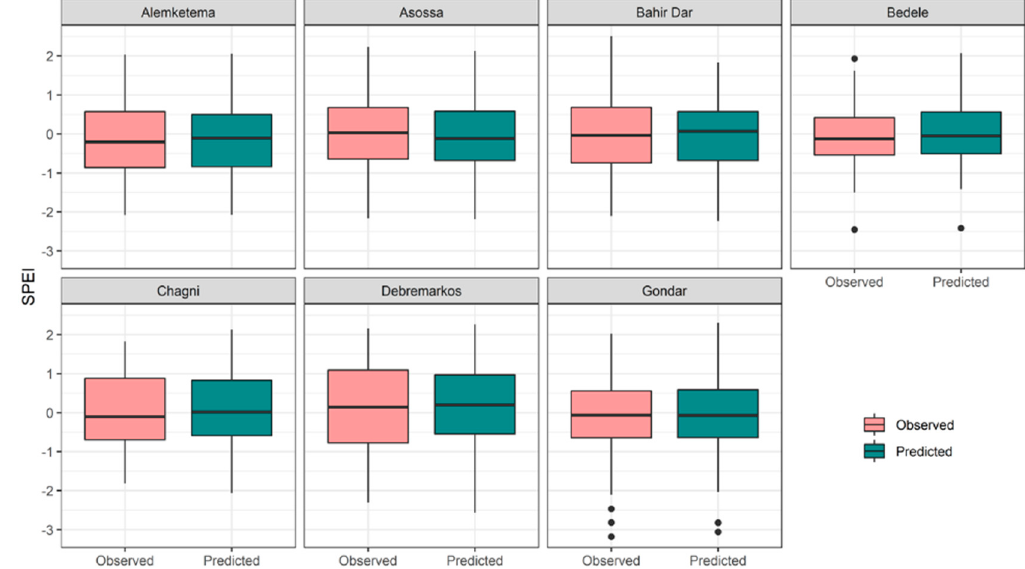
Figure 9. Box plots of the observed and predicted SPEI values plotted for the test period.